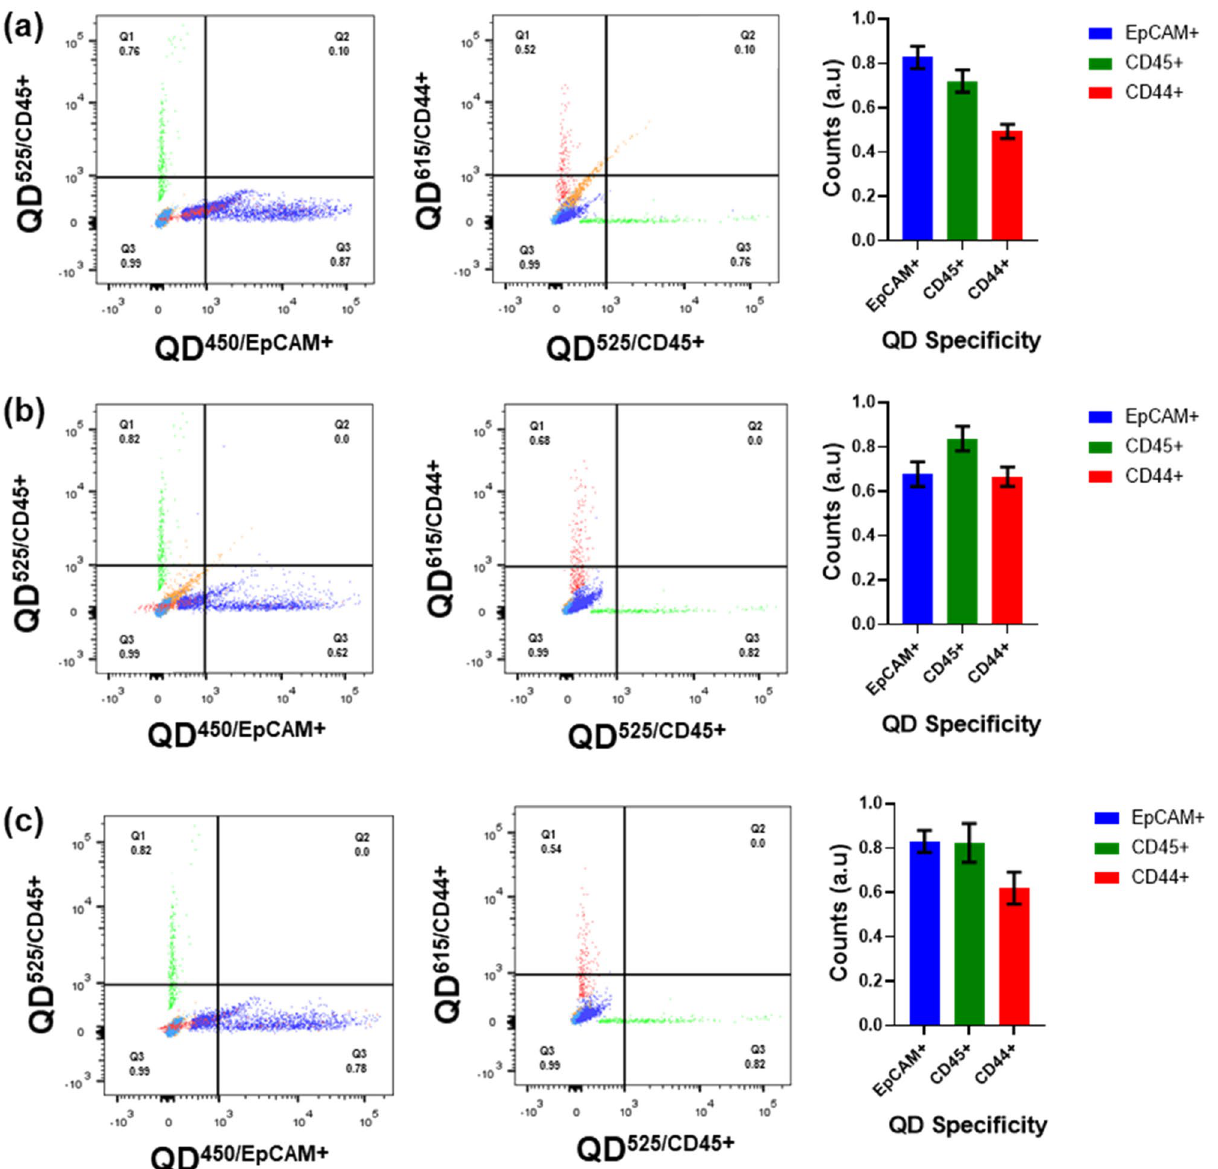
Figure 5. Flowcytometry graphical images for capture the EpCAM+ and EpCAM− cells by using the quantum dot conjugated with anti-EpCAM, anti-CD45 and anti-CD44 cells in co-culture cells in in-vitro incubated with concentrations at 1.0 μg/mL in 1 × PBS media were analyzed through flowcytometry ( a ) MCF-7 and THP-1 ( b ) HELA and THP-1 ( c ) HEK-293 and THP-1 cancer cell lines co-cultures with respective fluorescence emission and insight histograms shows the flowcytometry with respective Quantum dots binding. (The data is normalized to 1.0 which is equivalent to 100%, the data should be compared based on the relative normalized to